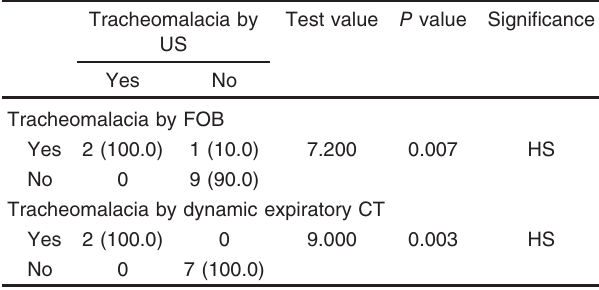
Table 13 Comparison between ultrasound, fiberoptic bronchoscopy, and dynamic expiratory computed tomography in the diagnosis of tracheomalacia among the nonintubated patients Tracheomalacia by